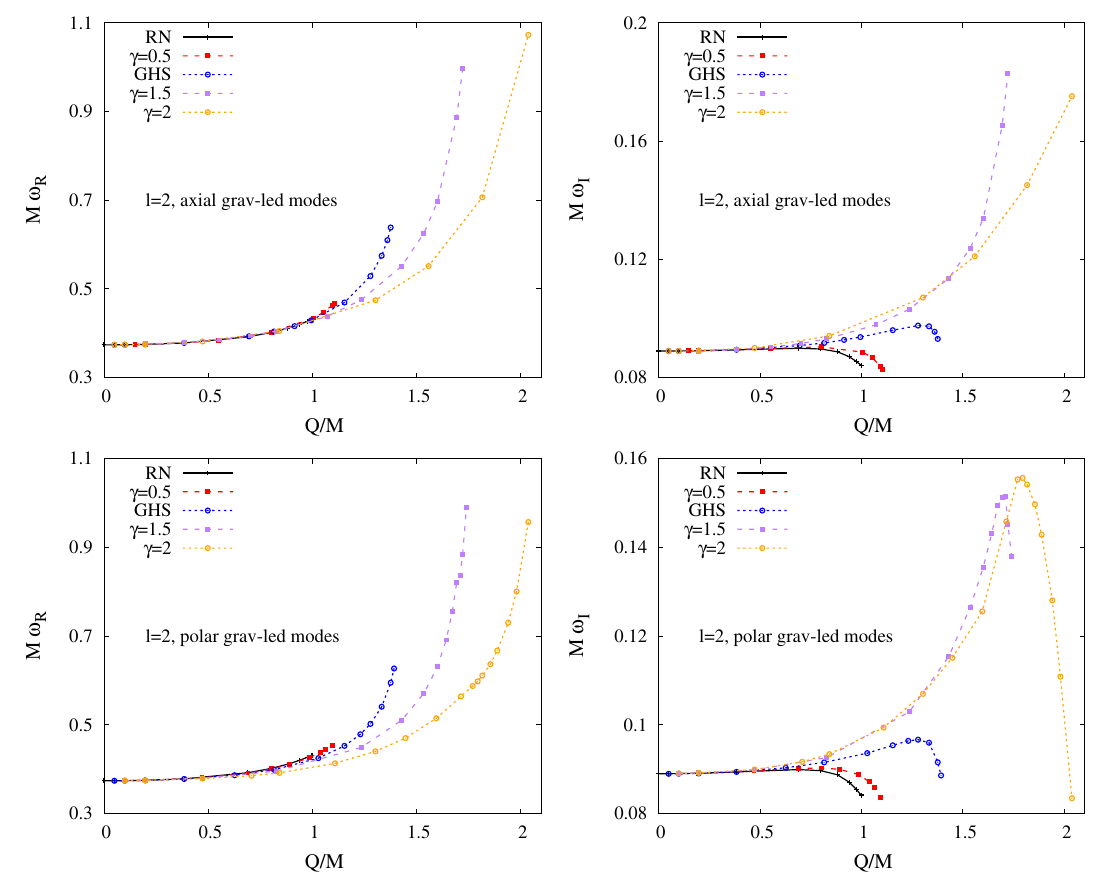
Fig. 7 Grav-led modes for l = 2 perturbations: axial (upper) and polar (lower)